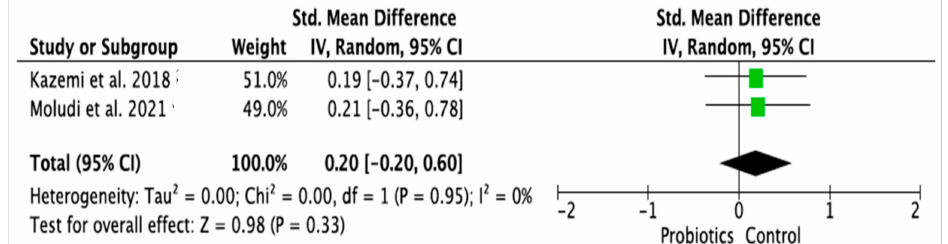
Figure 9. Forest plot for the effect of probiotic treatment on IL-10 level in probiotics and control groups [14,31]. Note: The green squares are the SMD for the post-hoc studies, the black rhombus is the graphical summary for all studies above.